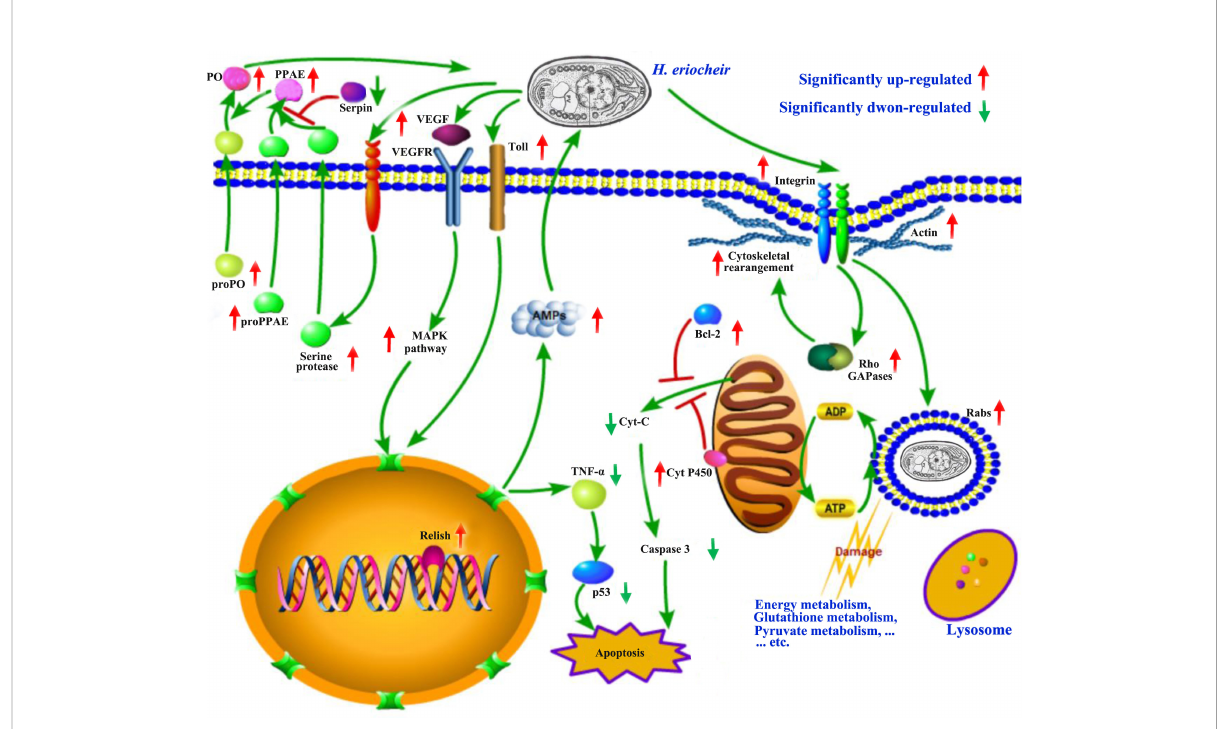
FIGURE 7 A schematic model of the major biological processes and pathways associated with infection of the E. sinensis intestine by H. eriocheir (generated by the Pathway Builder Tool). For abbreviations and explanations, see the